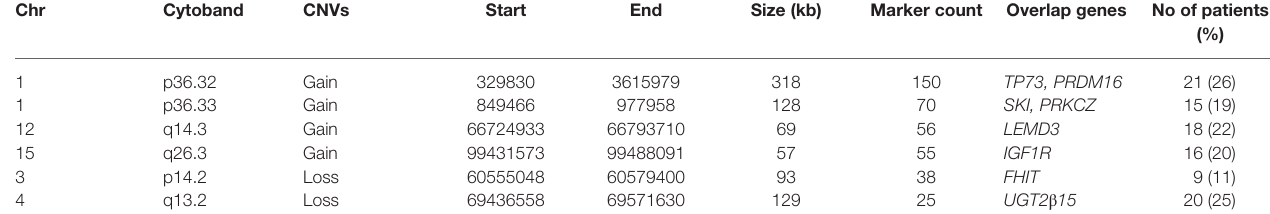
TABLE 3 | Distribution of significant CNVs among NSCL/P and noncleft with and without hypodontia ( n = 81). Chr